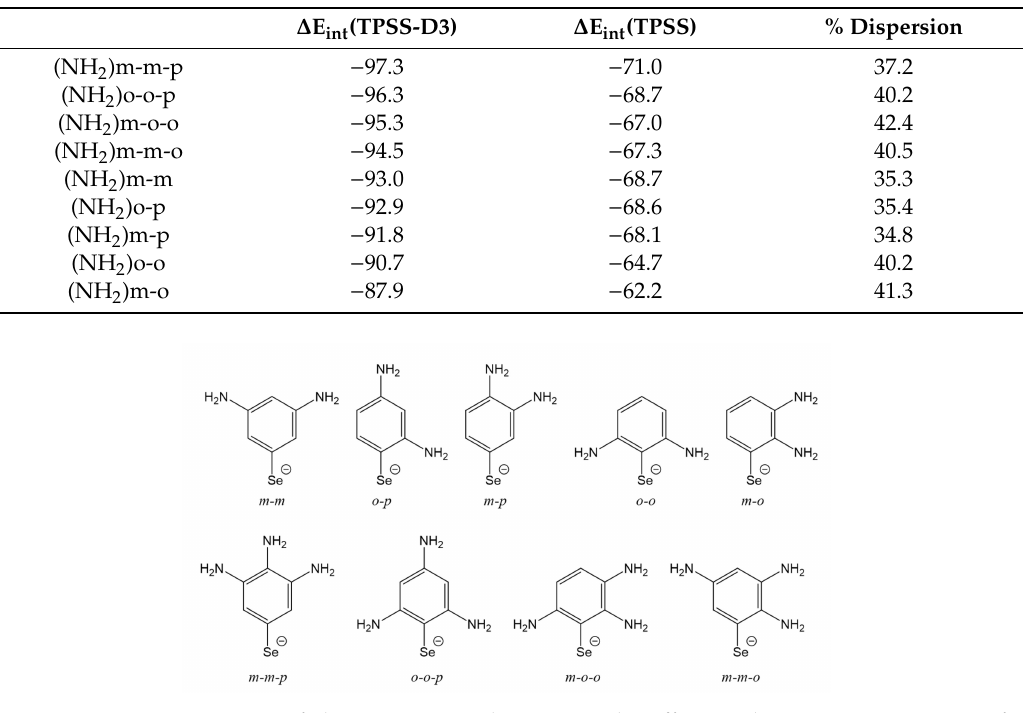
Figure 7. Representation of the systems used to assess the e ff ect in the interaction energy of multi-substitution of phenyl-selenophenolate ligands with two and three NH 2 functional